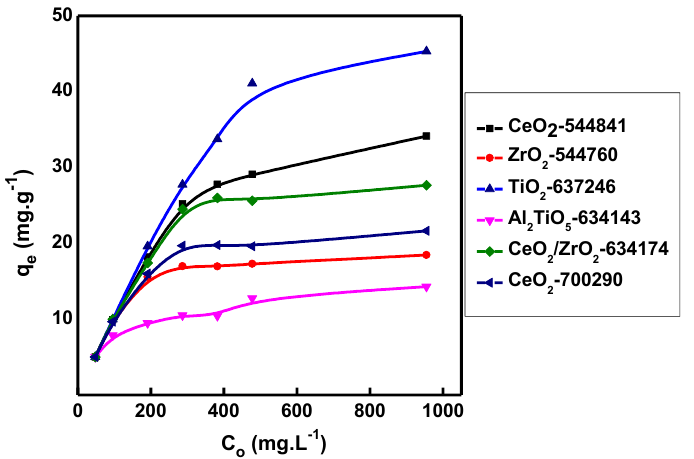
Figure 2. The influence of initial molybdate concentration on the equilibrium sorption capacity (q e ) of CA- 99 Mo on different metal oxides NPs (pH = 3, V/m =100 mL · g − 1 , t = 24 h, and temperature = 298 ± 1 K).